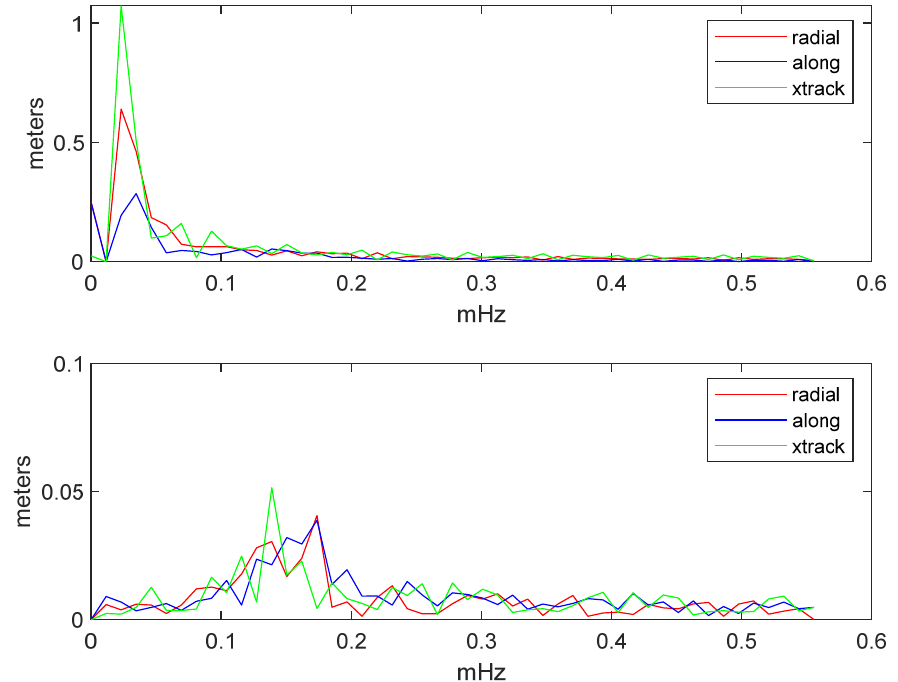
Figure 15. Spectrum of the pre-fit (top) and post-fit (bottom) residuals of the coordinates of the GPS satellites relative to the CNES precise ephemeris, projected on the radial, tangential and across track basis. Average values for January 2020.